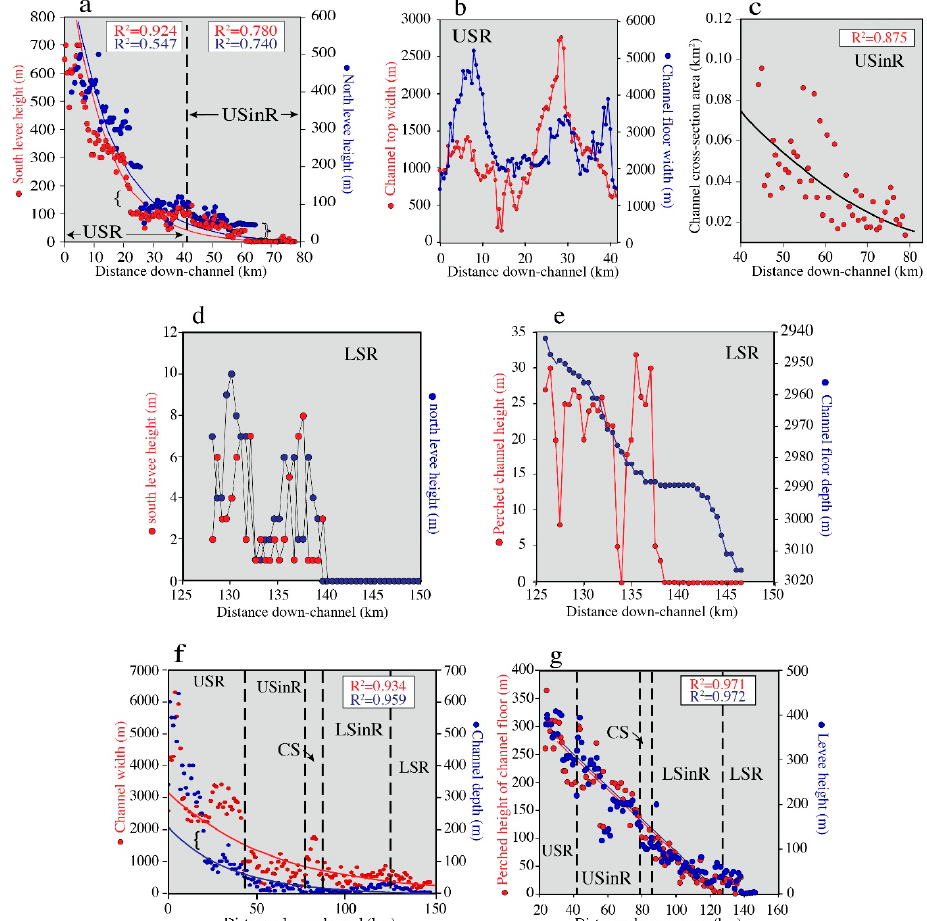
Figure 5. Plots of relationships between ( a ) upper straight reach (USR) and upper sinuous reach (USinR) levee heights vs. distance down-channel. Curly black bracket is gap in USR north levee heights in an otherwise smooth decrease and curly white bracket is gap in USinR north levee heights; ( b ) USR channel floor width and channel top width vs. distance down-channel; ( c ) plot of USinR channel cross-sectional area vs. distance down-channel; ( d ) plot of LSR levee heights vs. distance down-channel; ( e ) plots of LSR perched height above basin depth and depth of channel floor vs. distance down-channel; ( f ) plots of entire Mendocino Channel floor width and channel incision depth vs. distance down-channel. Curly bracket is gap in channel width and depth with down-canyon distance; ( g ) plots of entire Mendocino Channel perched height above basin depths and levee height vs. distance down-channel.